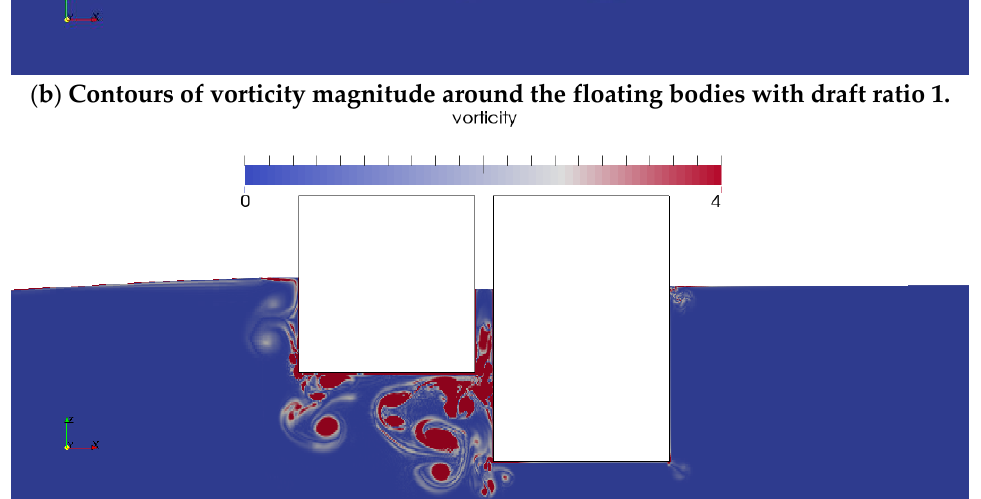
( b ) Contours of vorticity magnitude around the floating bodies with draft ratio 1.